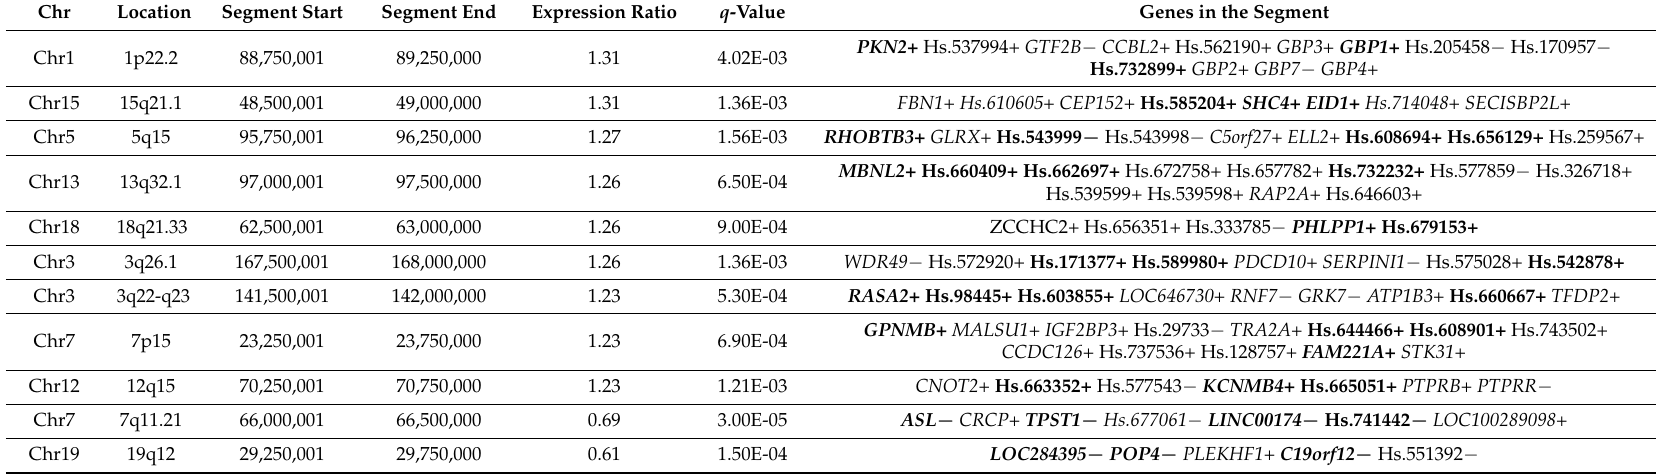
Table 4. Chromosomal segments statistically significant in TRAM “Map” mode analysis of male SN PD patient samples vs. male SN control samples (TRAM